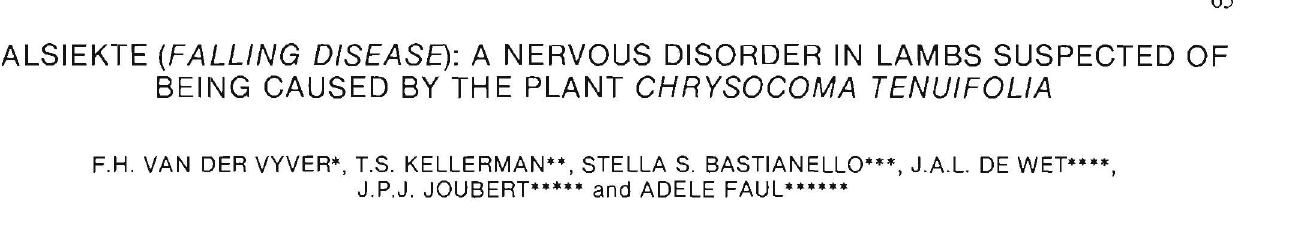
Fig. 1: A typical clinical presentation of 'Valsiekte', observed after lambs have been chased.